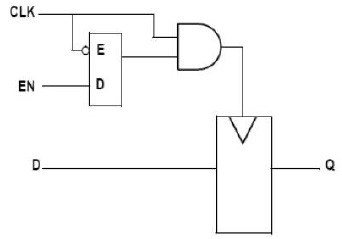
Figure 4. Local explicit clock gating (LECG).